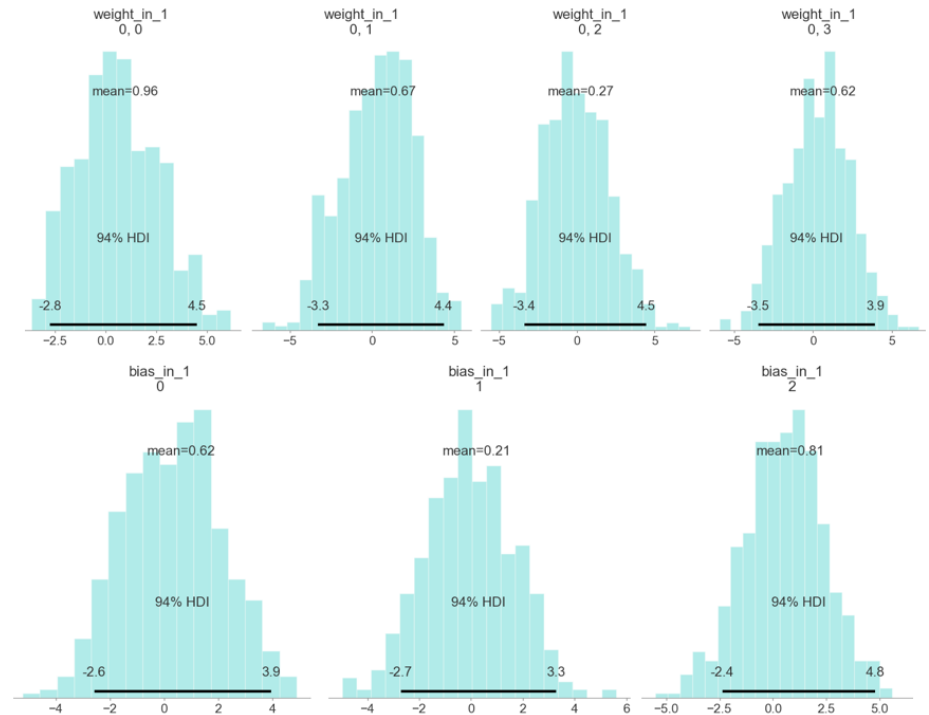
Figure 11. Trained weights and bias at links that connect input layer to first hidden layer at a 0.3 mean for tsunami in